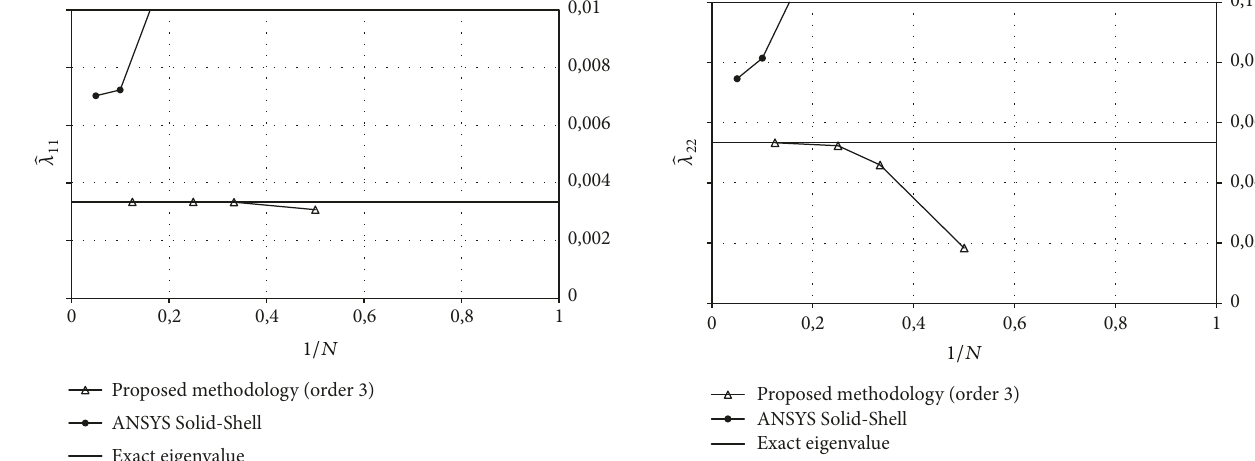
̂𝜆 1/𝑁 ( ℎ -conver- 11 versus